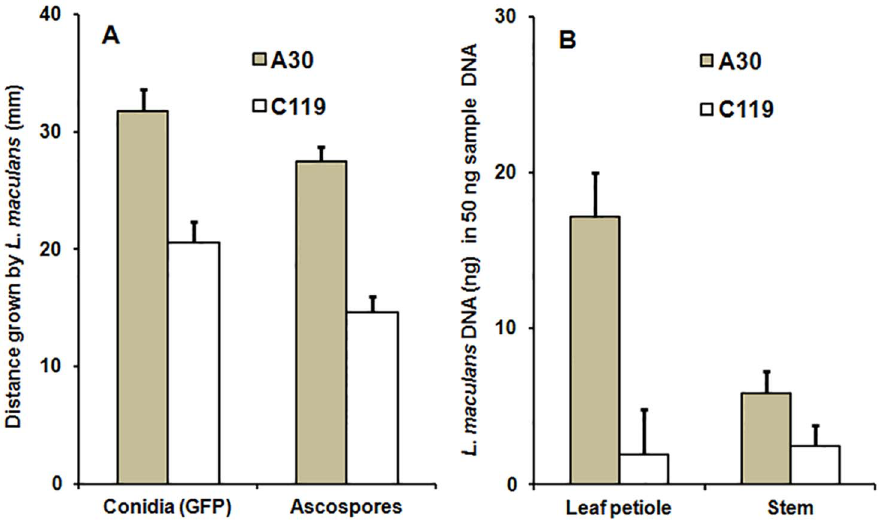
Figure 4. Distance grown along leaf petioles and Leptosphaeriamaculans DNA in petioles and stems. Leaf laminas or leaf petioles of doubled haploid lines A30 (susceptible) or C119 (with quantitative resistance) were inoculated with conidia of GFP-expressing L. maculans isolate ME24/3.13 or ascospores from a natural population. The distance grown by L. maculans along the leaf vein/petiole towards the stem (leaf lamina inoculation, Fig. 2A) was measured by assessing extent of GFP fluorescence at 22–25 days post inoculation (dpi) for conidial inoculation (A) or by assessing extent of the visible necrosis (A) and by quantification of amount of L. maculans DNA (B) using qPCR at 18–20 dpi for ascospore inoculation. The growth of L. maculans in stem tissue (petiole inoculation, Fig. 2B) was assessed by quantification of amount of L. maculans DNA using qPCR (B) at 46 dpi inoculation with ascospores. Bars show standard errors (A, 28 d.f. for conidia and 54 d.f. for ascospores; B, 54 d.f. for leaf petiole and 50 d.f. for stem).